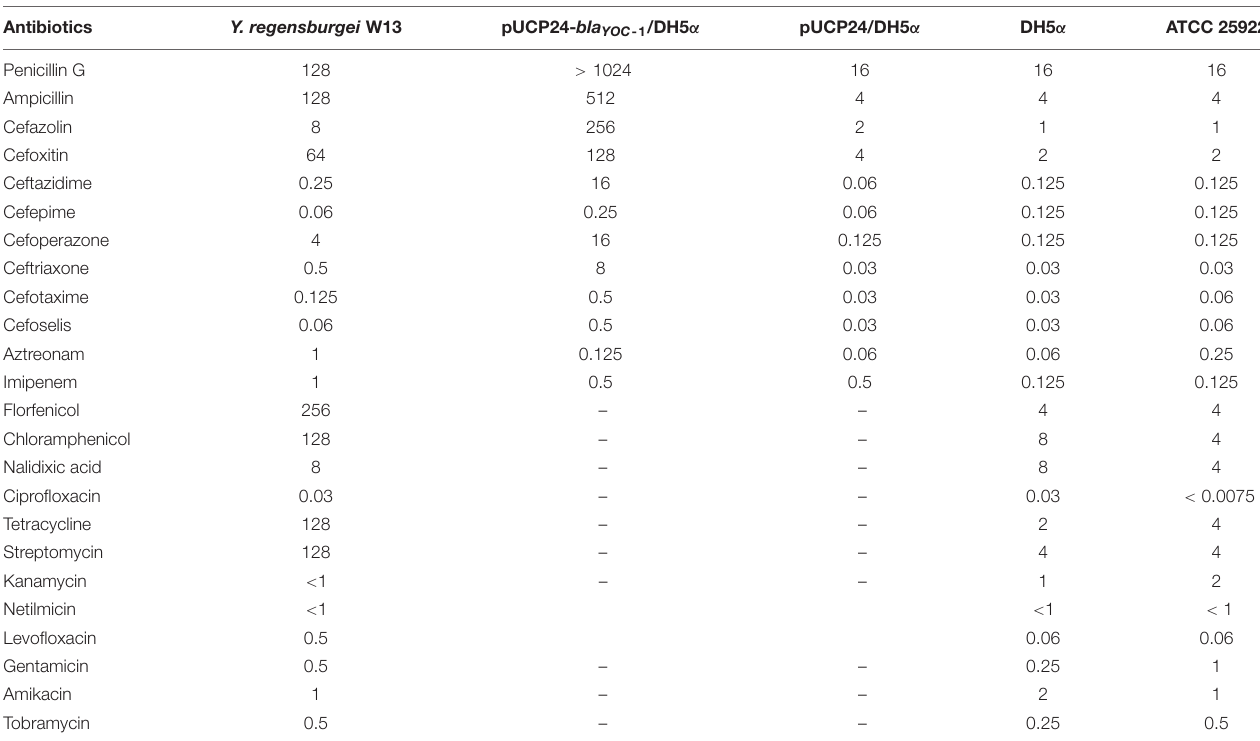
TABLE 4 | MICs of 24 antibiotics for 5 strains ( µ